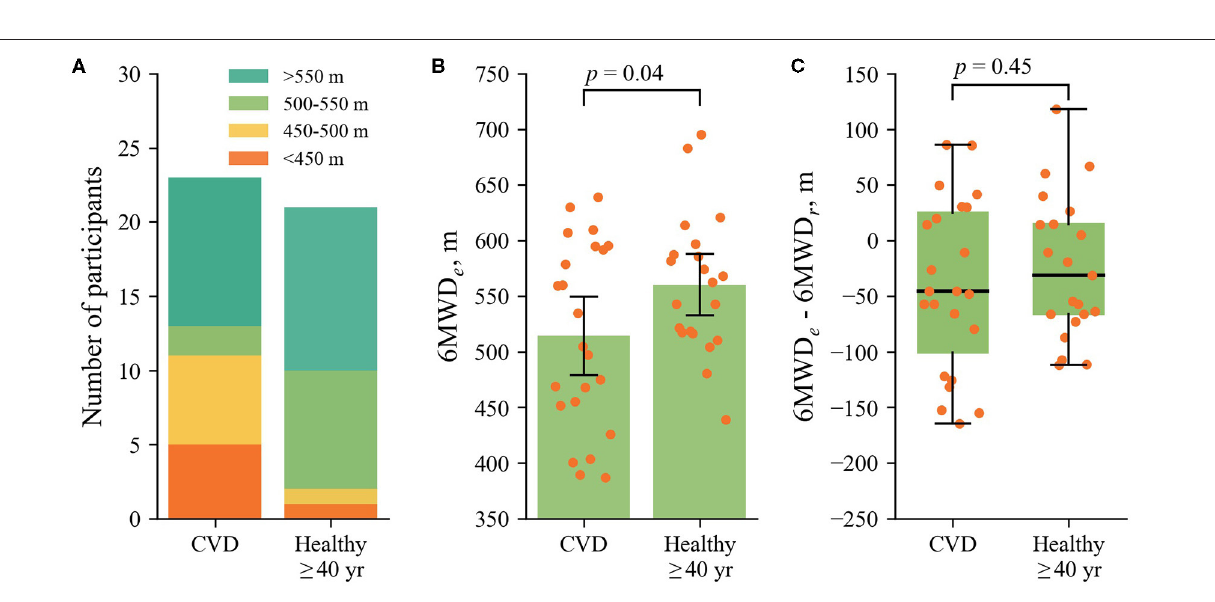
FIGURE 6 | (A) Stacked diagrams of the 6MWD e for the different groups of subjects. (B) The 6MWD e for the different groups, where the dots display individual 6MWD e values. (C) The difference between the 6MWD e and the 6MWD r . The group of healthy subjects below 40 years is not included since the equation for the reference walking distance is not validated for younger individuals.